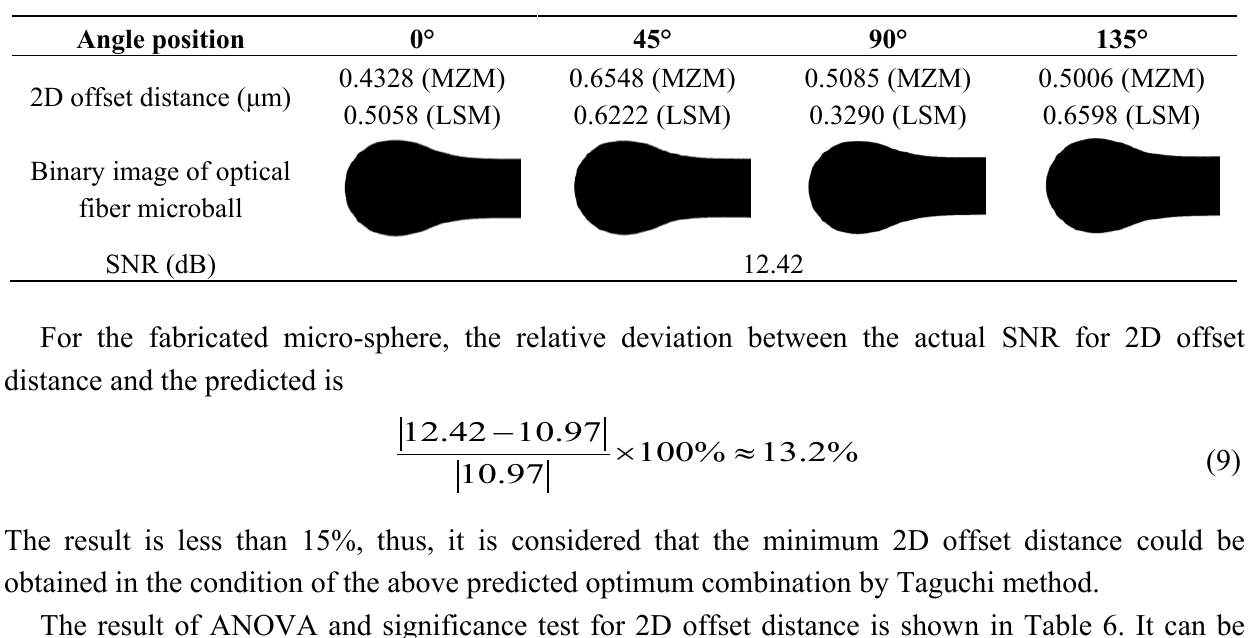
Table 5. Result of 2D offset distance in the condition of optimum combination.